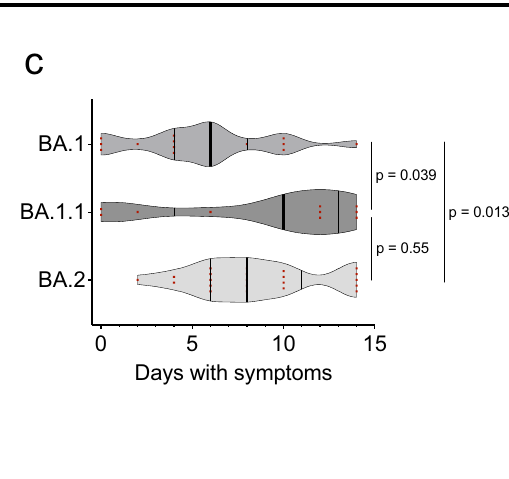
Fig. 4 | Post booster WT spike-speci fi c IgG levels with comparisons between subsequent omicron sublineage breakthrough infections. a Post booster WT spike-speci fi c IgG titers in participants that remained qPCR negative ( n =287) and in participants who tested positive with BA.1 ( n =19), BA1.1 ( n =13) or BA.2 ( n =22) infectionduringthescreeningperiod. b CtvaluesinqPCRpositiveparticipantsthe fi rst 15 days of breakthrough infection with BA.1, BA.1.1 and BA.2. c Number of symptomatic days for participants who tested positive with BA.1, BA1.1 or BA.2